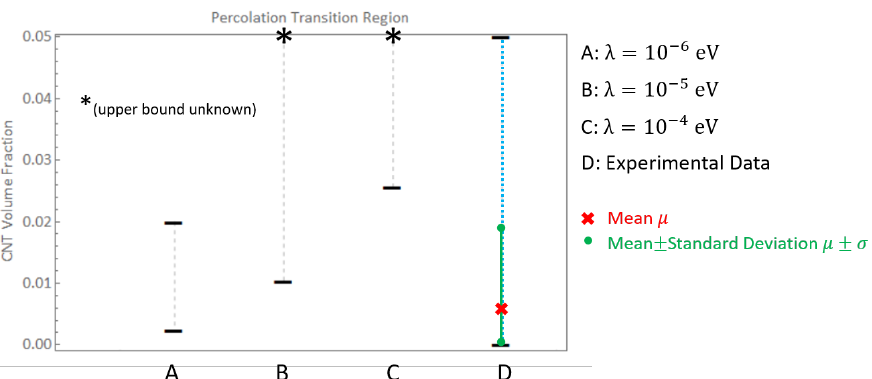
Figure 21. Percolation transition region depicted for Σ 11 = Σ 22 for straight randomly oriented cases for 3 different barrier potentials; CNT volume fraction range depicted by D from review study